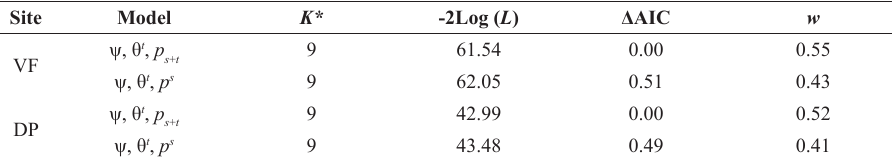
Table 3. Occupancy probabilities model selection. Summary of the model selection statistics for the study of O. eremita during 2014 in PA (PA = Parco Nazionale d’Abruzzo Lazio e Molise; VF = Val Fon- dillo; DP = Difesa di Pescasseroli).